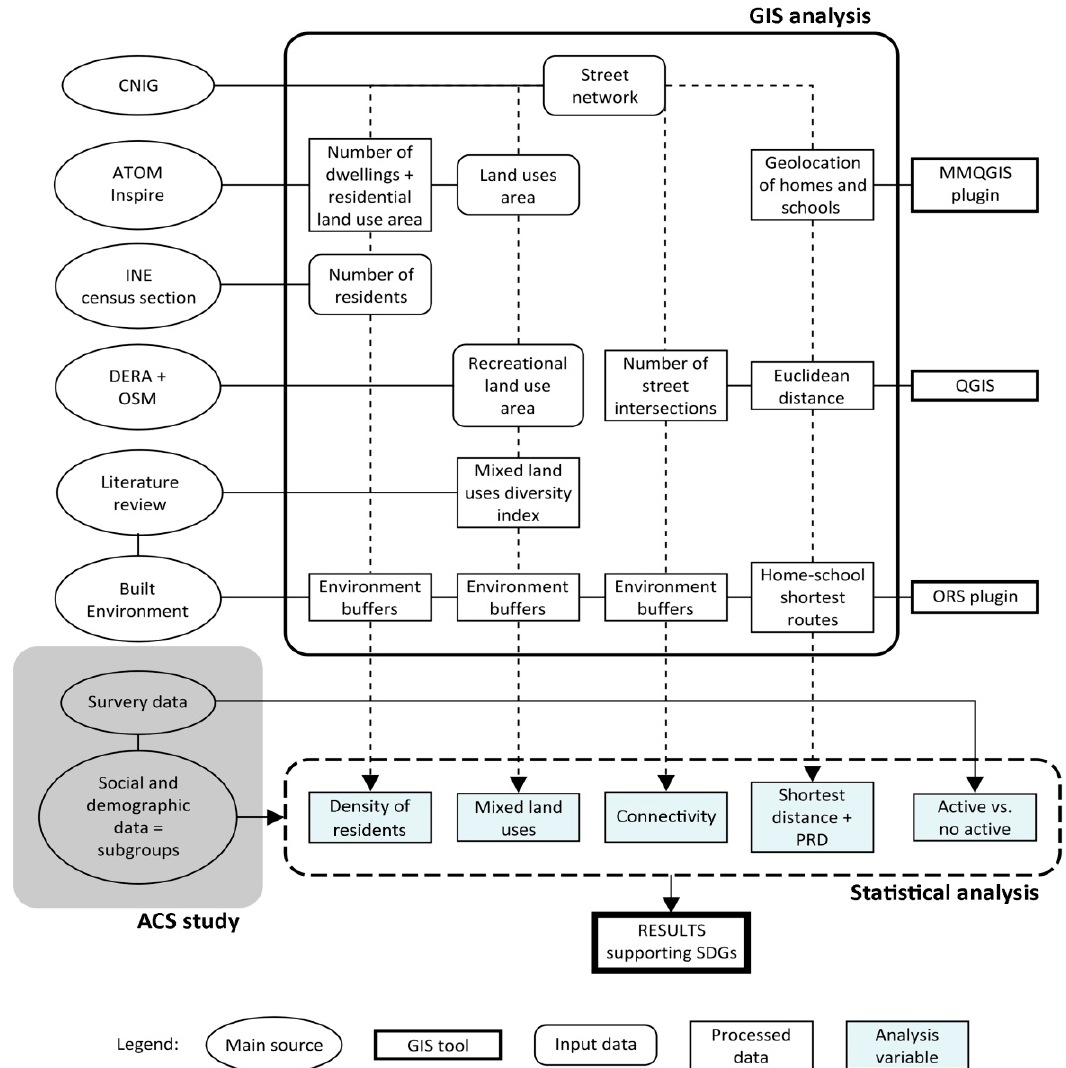
Figure 1. Method workflow. Abbreviations: CNIG: National Centre for Geographic Information.